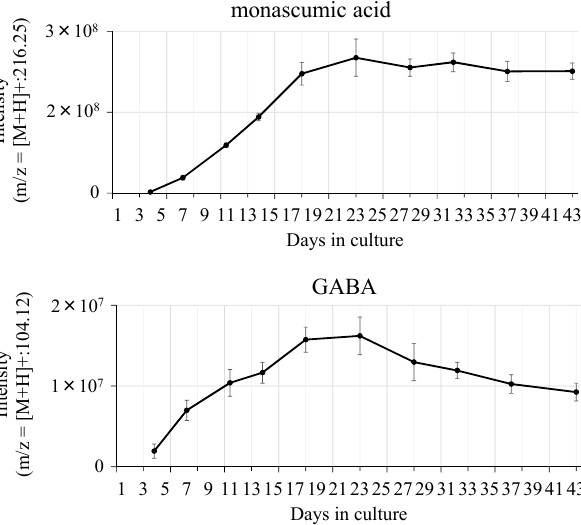
Figure 11. Time course change in the contents of 2 amino acids (GABA and monascumic acid) in red yeast rice during fermentation, quantified by liquid chromatography-mass spectrometry (LC-MS) [16,17].